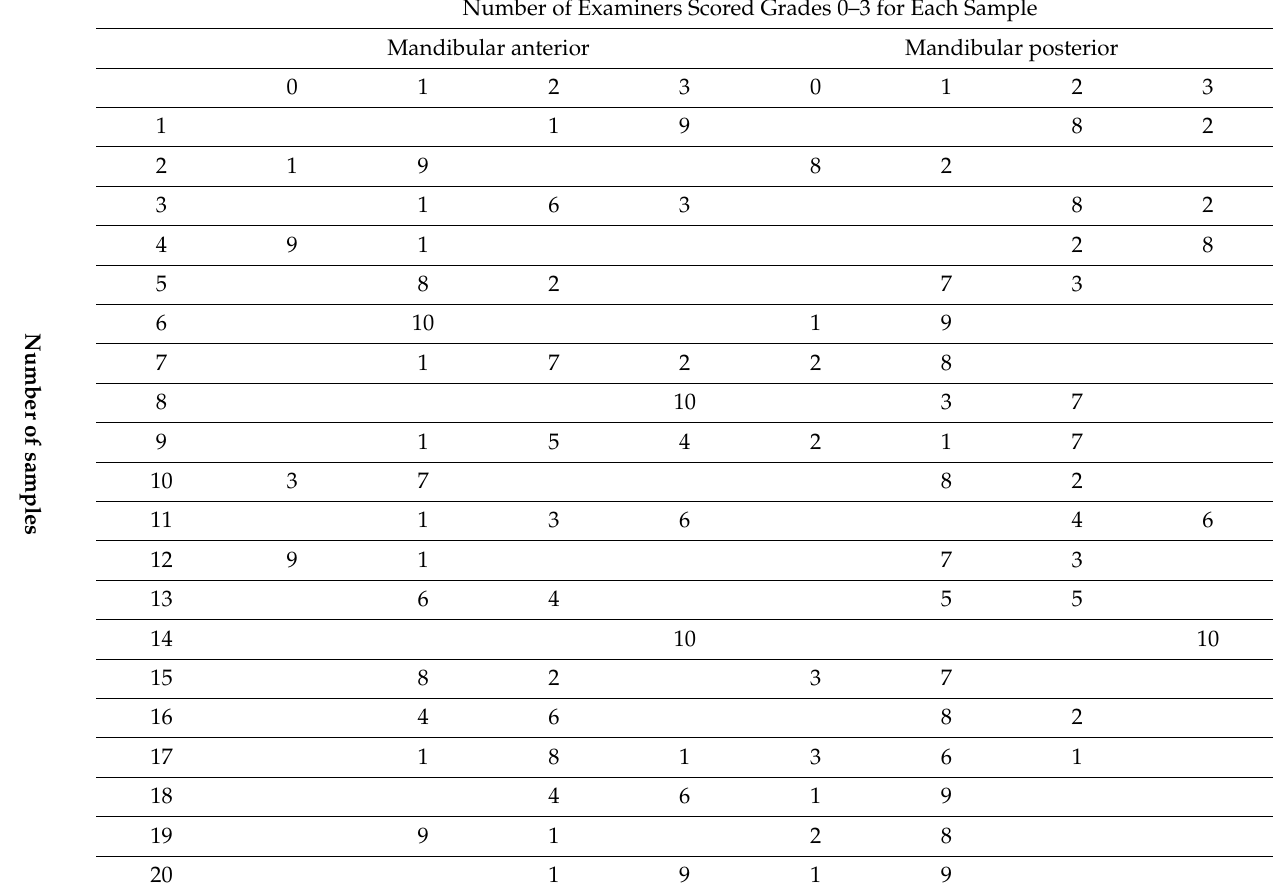
Table 4. Range of agreement between examiners in each case (lower